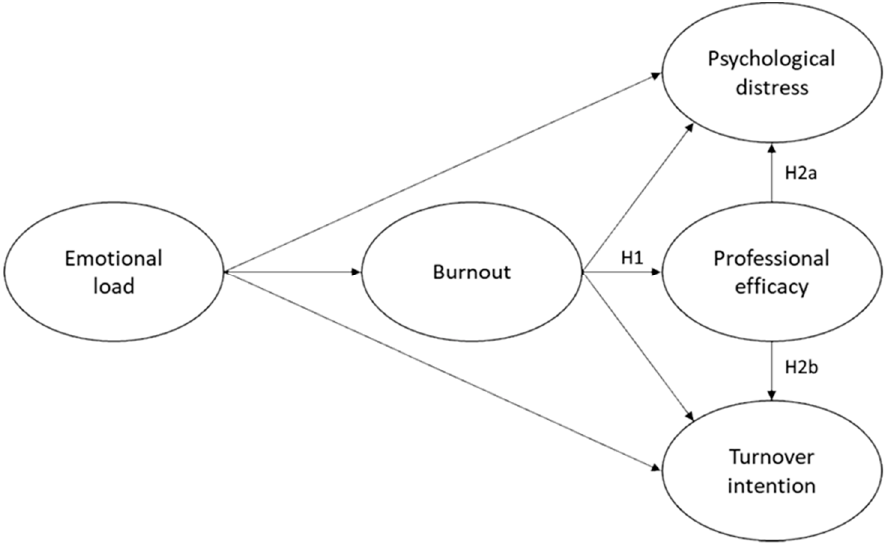
Figure 1. The research model.